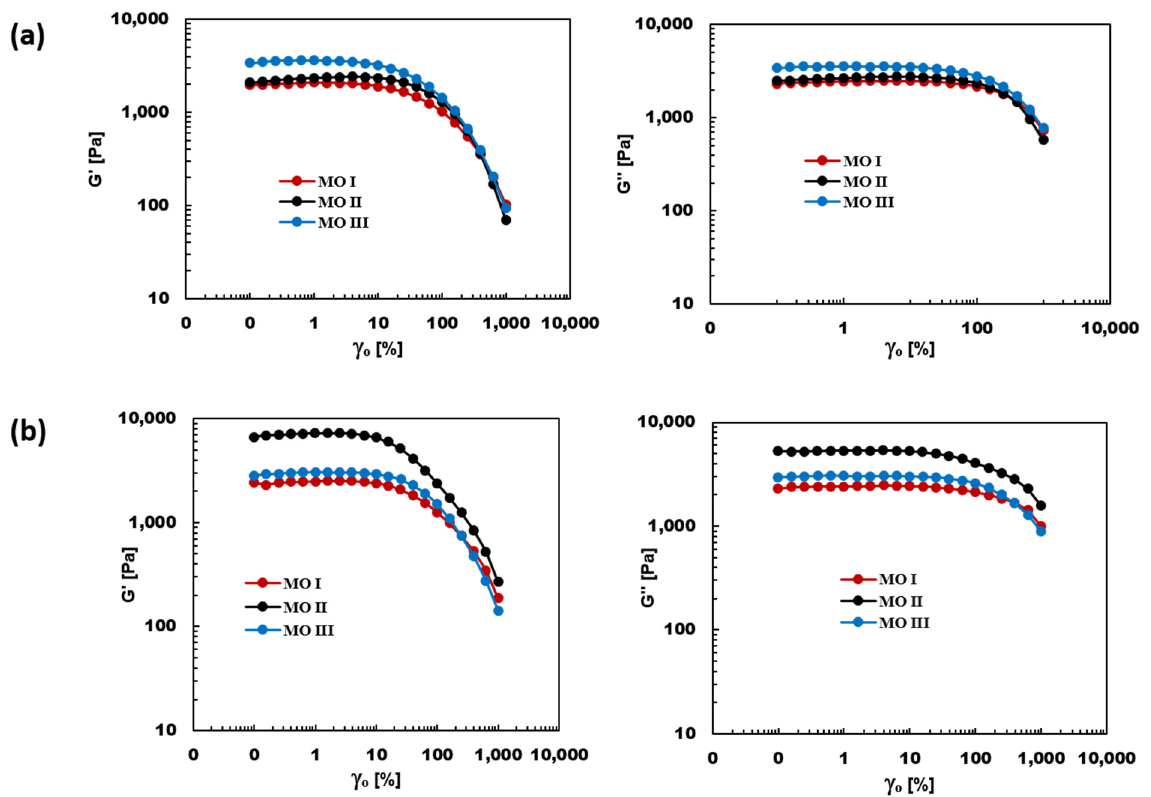
Figure 13. Storage (G ′ ) and loss modulus (G ″ ) of PS/aPA6 nanocomposites containing 1.5 vo1% CNT at ( a ) 1 vol% PSMA ( b )3 vol% PSMA prepared using three different mixing orders.